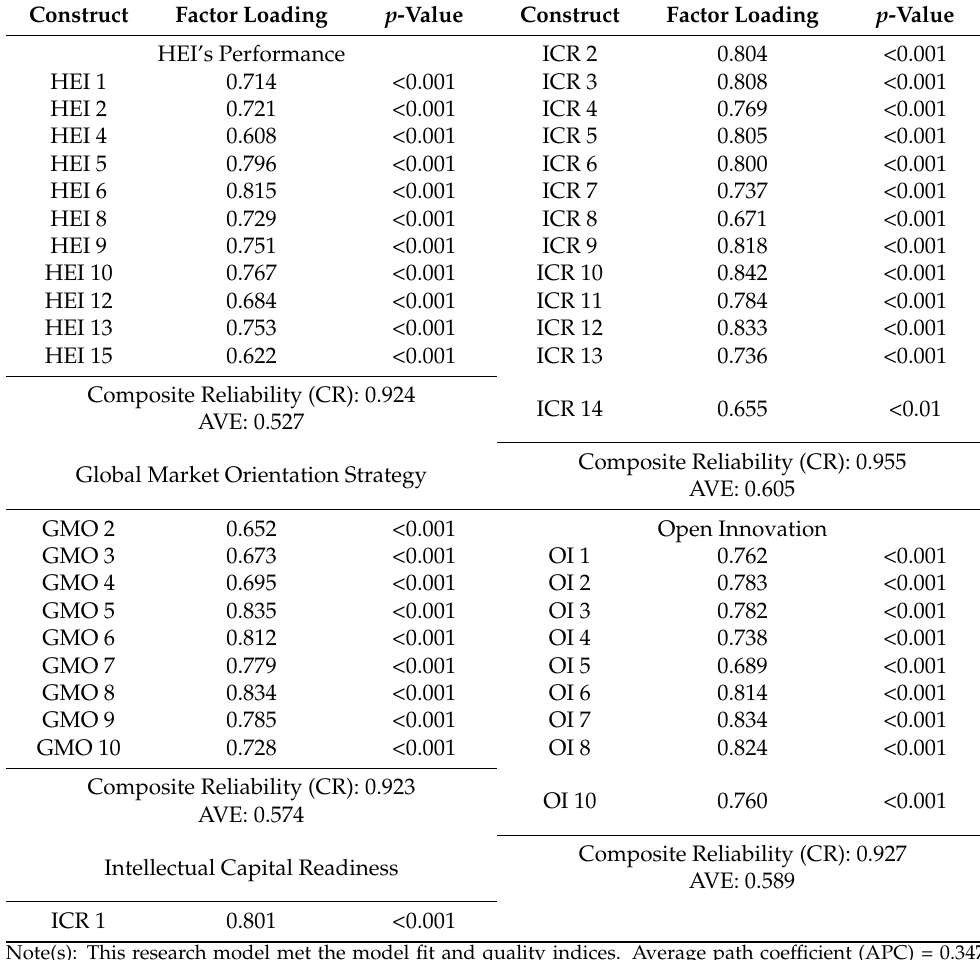
Table 4. Results of measurement model analysis.